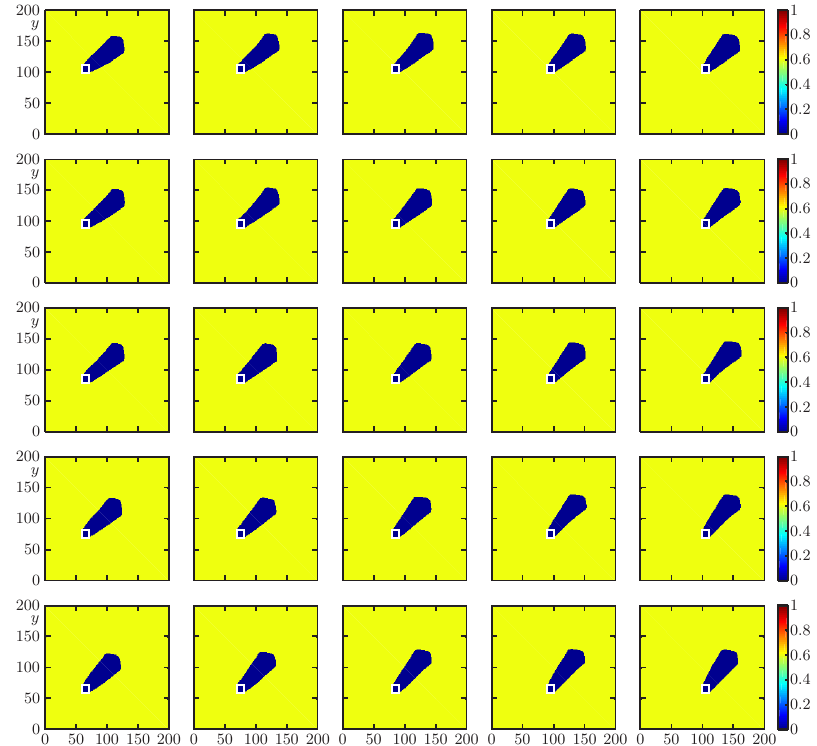
Figure 12. Scenario 3.3: simulation of fuel of a wildfire from 5 small white squares, on a domain with topography